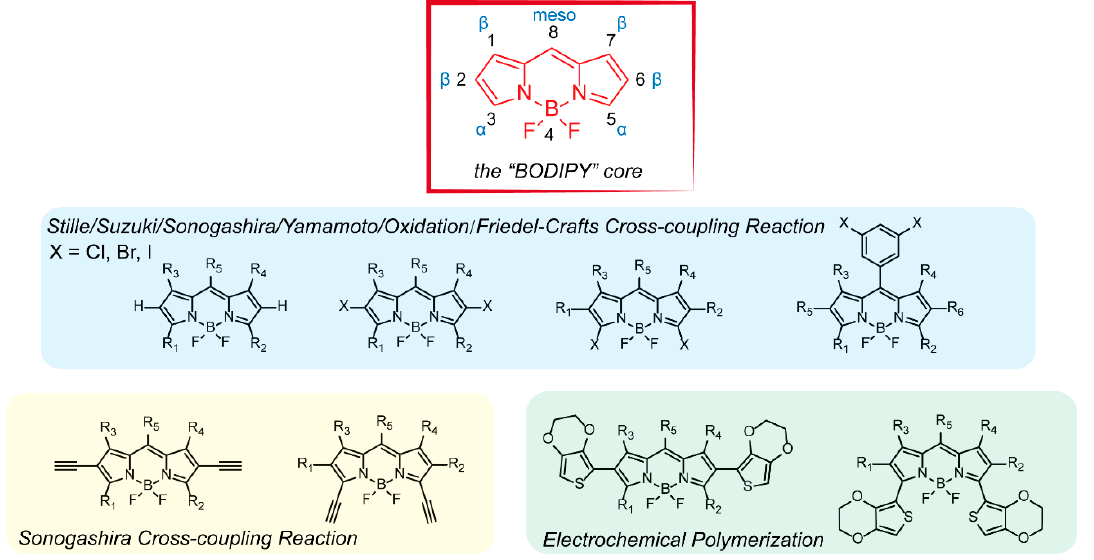
Figure 1. Structural representation of the 4,4 ′ -Difluoro-4-bora-3a,4a-diaza-s-indacene (BODIPY) core and BODIPY intermediates suited to polymerization via transition metal–catalyzed polycondensation reactions or electrochemical polymerization.